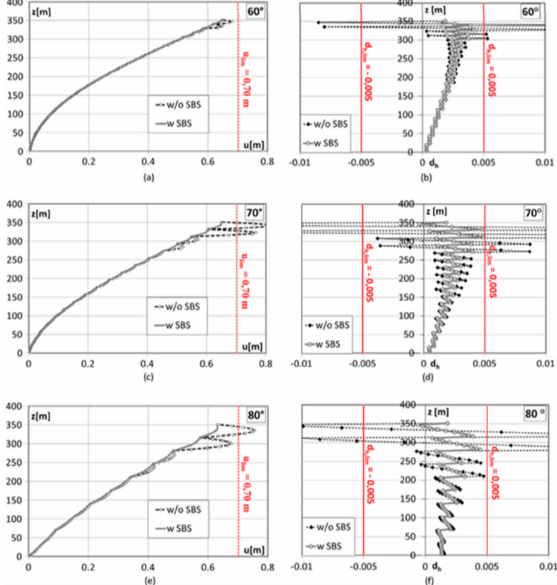
Figure 14. E ffi cacy of secondary bracing system (SBS) in limiting inter-story drifts: ( a , b ) 60 ◦ ; ( c , d ) 70 ◦ ; ( e , f ) 80 ◦ diagonal pattern. ( a , c , e ) lateral deflections; ( b , d , f ) inter-story drift ratios. Used with permission from Montuori et al.